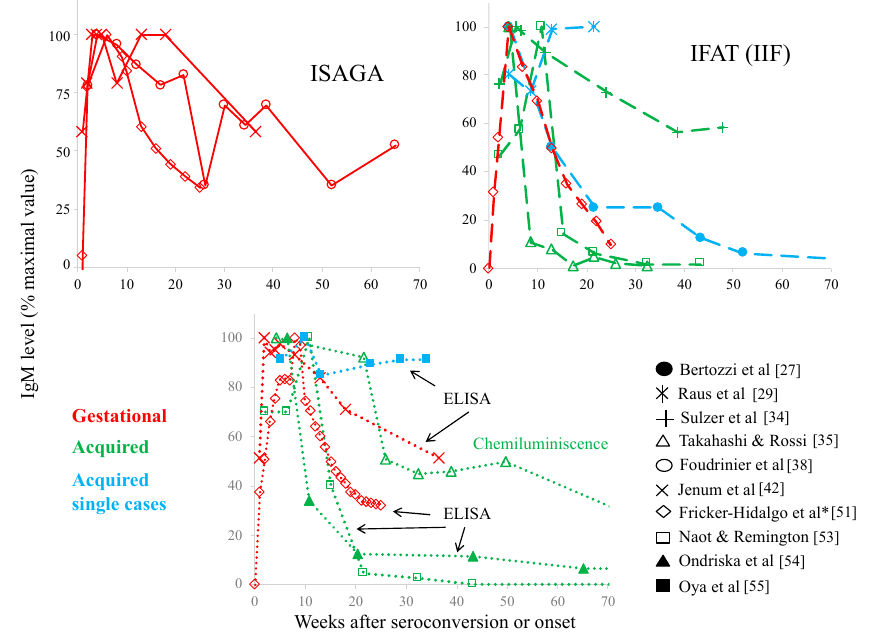
Figure 3. Kinetics of IgM antibody levels reactive to T. gondii in different groups after initial clinical or serological signs of infection [27,29,34,35,38,42,51,53–55]. The IgM levels were normalized to percentage of the maximum value in order to compare among studies. Dispersion data are not displayed (even if reported). The plots are separated according to the test performed. Acronyms of tests are as in Figure 2. The x -axis also cuts off at 70 weeks, but two studies followed patients for longer periods. * Fricker-Hidalgo et al. compared techniques, but we could only gather data from ISAGA, IFAT and ELISA.